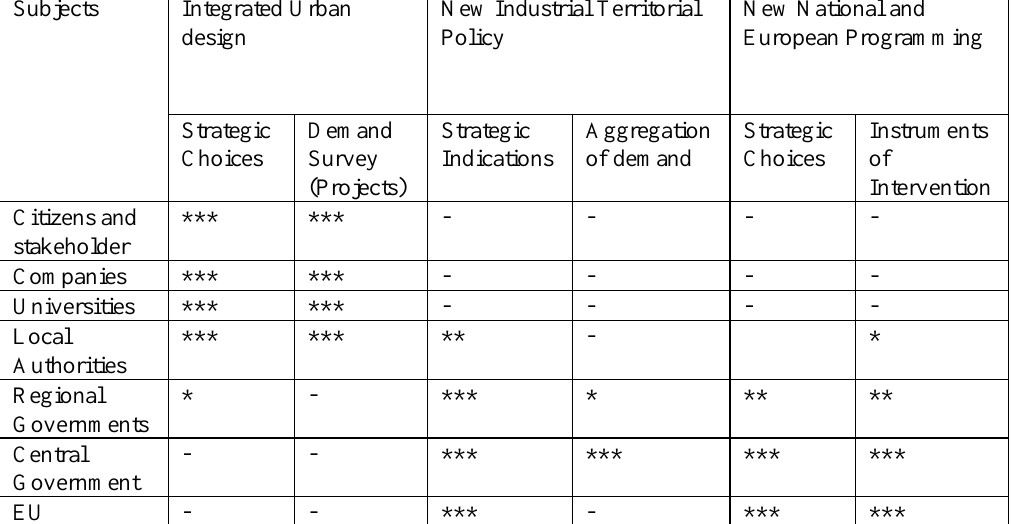
Table 1: Scheme of Industrial-Territorial Policies Subjects Integrated Urban